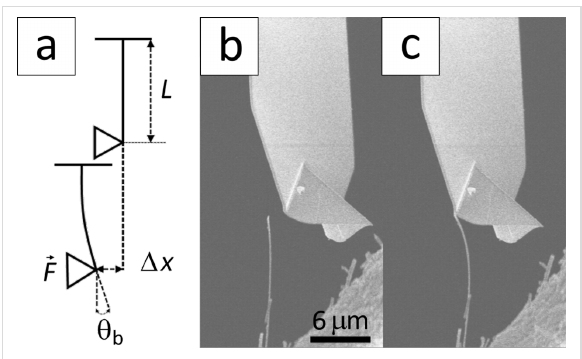
Figure 4: a) Schematic of the static bending of a single Sb 2 S 3 NW. SEM images of the NW b) in a relaxed state and c) under bending